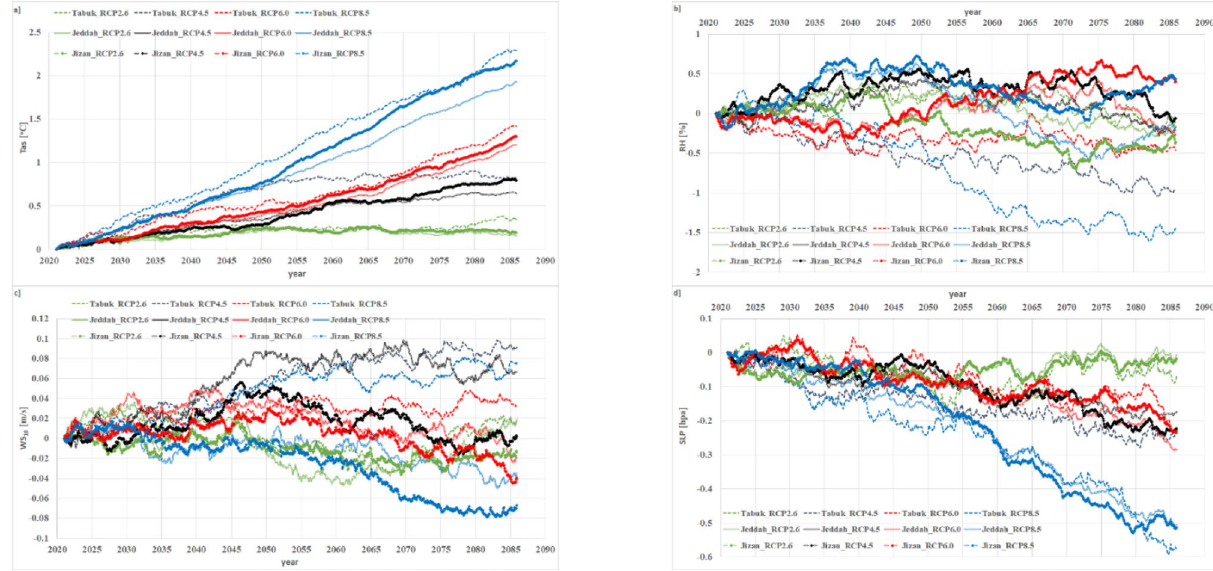
Figure 12. Thirty-year running annual means for ( a ) Tas (2-m air temperature), ( b ) RH (relative humidity), ( c ) WS 10 (surface wind speed), and ( d ) SLP (mean sea level pressure) anomalies with reference to the 2006–2020 average values for statistical downscaling of the GFDL mini-ensemble mean simulations. Math Works,